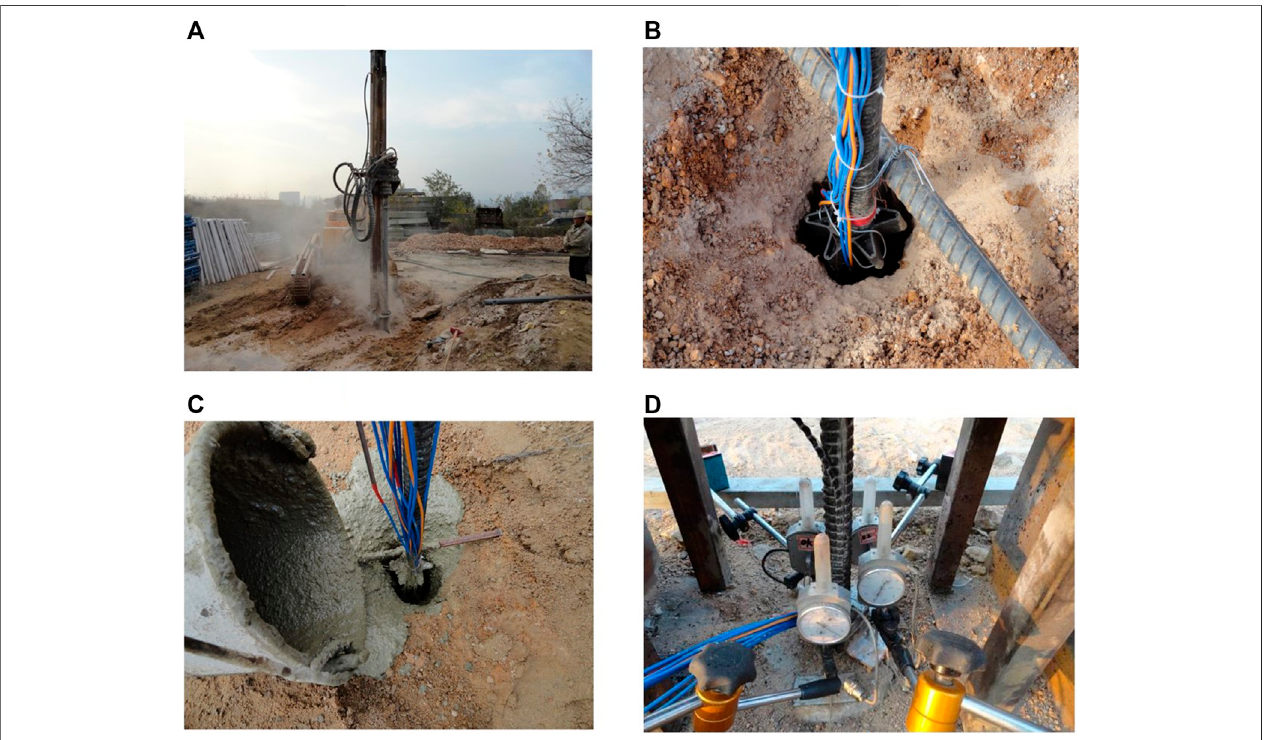
FIGURE 4 | Pull test procedure for GFRP anchor: (A) drilling borehole, (B) installing the anchor into the borehole, (C) pouring M30 cement mortar, and (D) pulling test.